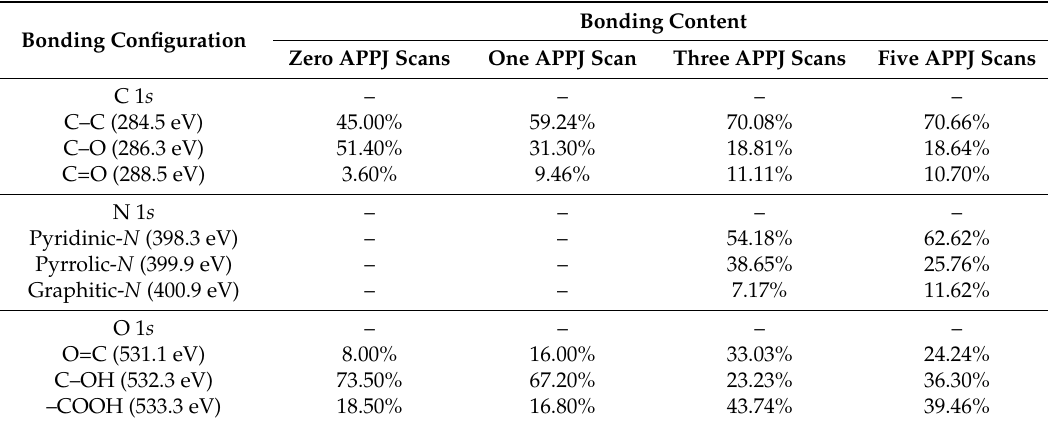
Figure 5. XPS spectra of ( a ) C 1 s , ( b ) N 1 s , and ( c ) O 1 s for screen-printed rGOs on carbon cloth with/without APPJ treatment. Table 1. Bonding contents analyzed from XPS spectra shown in Figure 5.